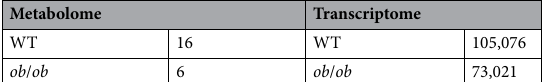
Table 1. The number of the edges with the difference in the value of mutual information. The number of the edges, which showed significantly different value of mutual information ( p < 0.05, permutation test) in the P to P edges (described in Fig. 3B) in the metabolome (left) and transcriptome (right),